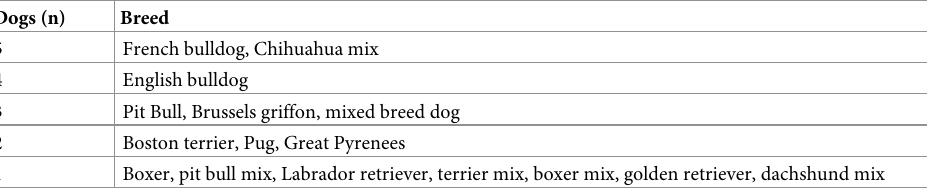
Fig 1. A-C: Infrared thermographic regions of interest (ROI). Infrared thermographic images depicting ROIs which are outlined in black (arrowhead). A) The ventral ROI was drawn to overly the larynx by centering over the ventral neck between the thoracic inlet and the ramus of the mandible. B) The dorsal ROI was drawn over the bridge of the nose between the medial canthi and extending rostrally to the start of the nasal planum. (C) The rostral ROI is drawn to include the nose with nares. Thermal scales are provided to the right of the images.